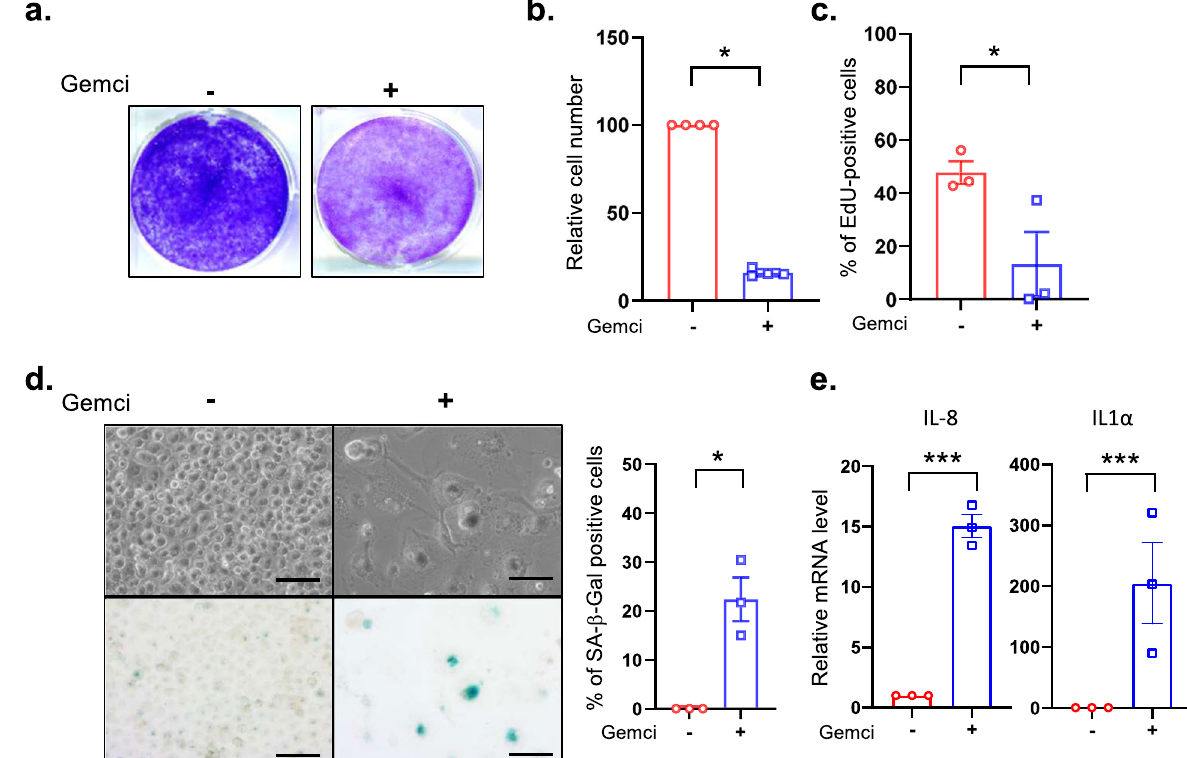
Fig. 1 Chemoresistant Capan2 cells display senescence features in response to gemcitabine treatment. Capan2 cells were treated with gemcitabine at 1395 nM. a , Four days after treatment, cells were fixed and stained using crystal violet. b‑c , Three thousand cells were seeded onto 96‑well plates and treated or not with gemcitabine. Three days later, cells were incubated with EdU for 1 h before fixation and staining of EdU‑positive cells and of the nuclei with Hoechst were performed. Images were automatically acquired using an Operetta imaging system before quantification of the number of cells ( b ) and of the percentage of EdU‑positive cells ( c ) ( n after treatment, cells were fixed and stained for SA‑β‑Gal activity. Representative images are shown and percentage of positive cells was calculated ( n 3, mean / SEM, Paired Student t‑test). e , RT‑qPCR against IL‑8 and IL1α on gemcitabine treated or not treated cells were performed and = + − normalized to TBP level ( n 3, mean / SEM, Paired Student = + −